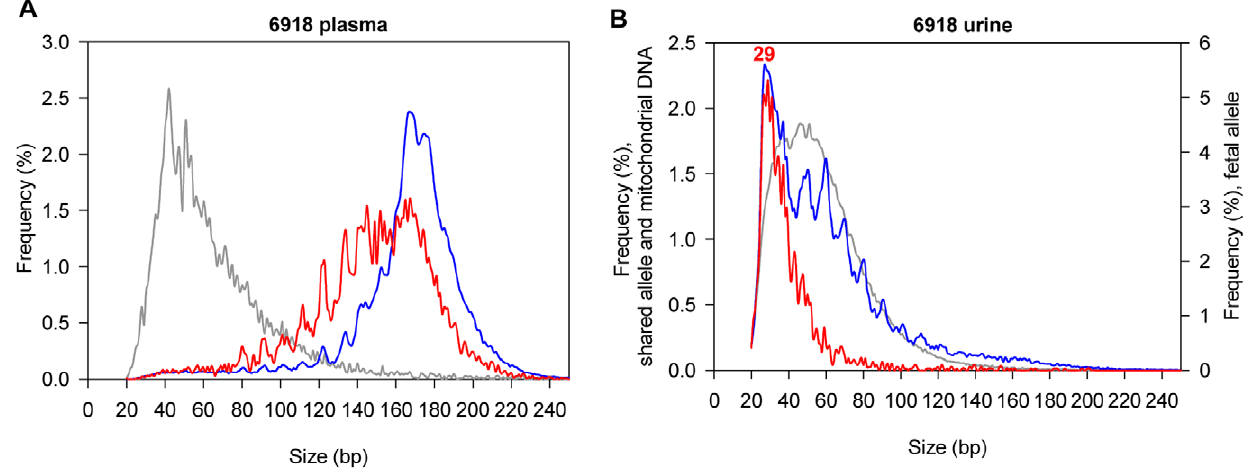
Figure 3. Comparison of size distributions between plasma and urinary DNA fragments. Size distributions of fetal DNA (red curves), maternal DNA (blue curves) and mitochondrial DNA (grey curves) in (A) maternal plasma and (B) maternal urine of case 6918. The number denotes the DNA size of the predominant urinary fetal DNA peak.